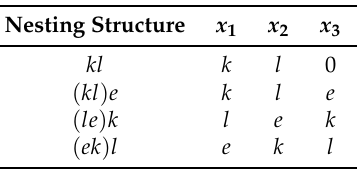
Table 1. Nesting structures for CES